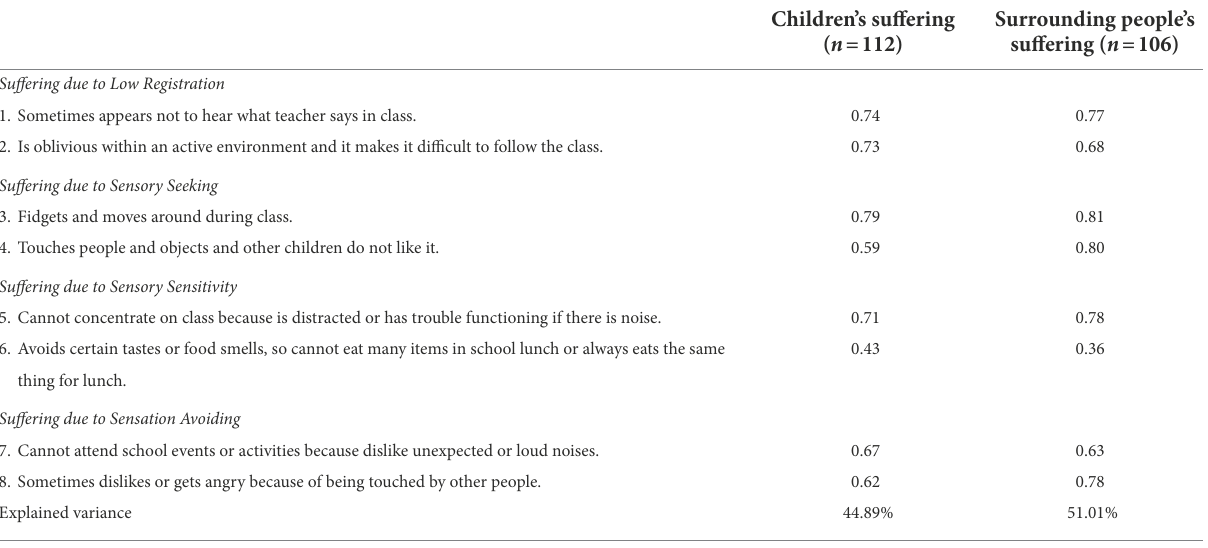
TABLE 1 PCA of suffering due to sensory symptoms.